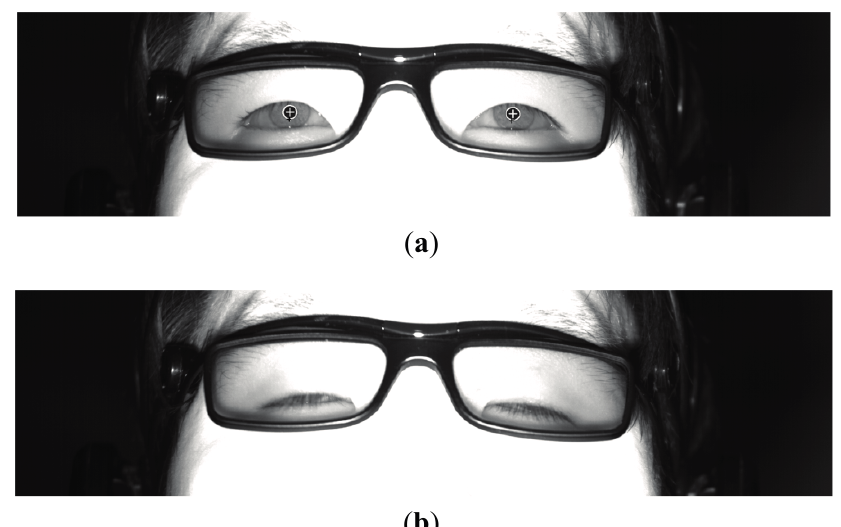
Figure 5. Example of measurement of eye blinking. ( a ) Open eyes; ( b ) Closed